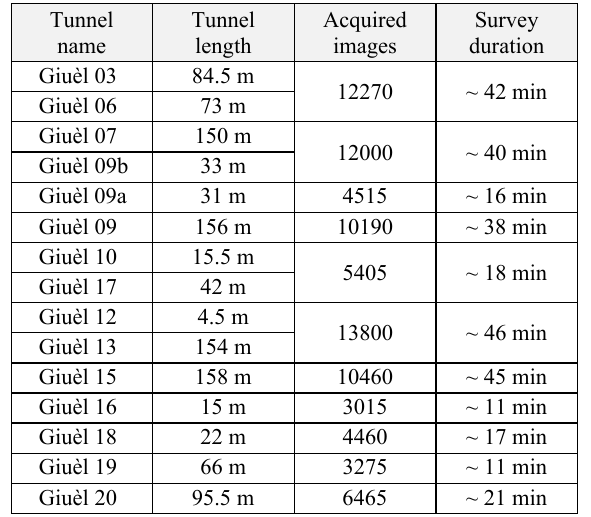
Figure 3. Sparse pointcloud of tunnels: 13 and 15 (top two) and view of the full resolution mesh model of tunnel 13 (bottom).